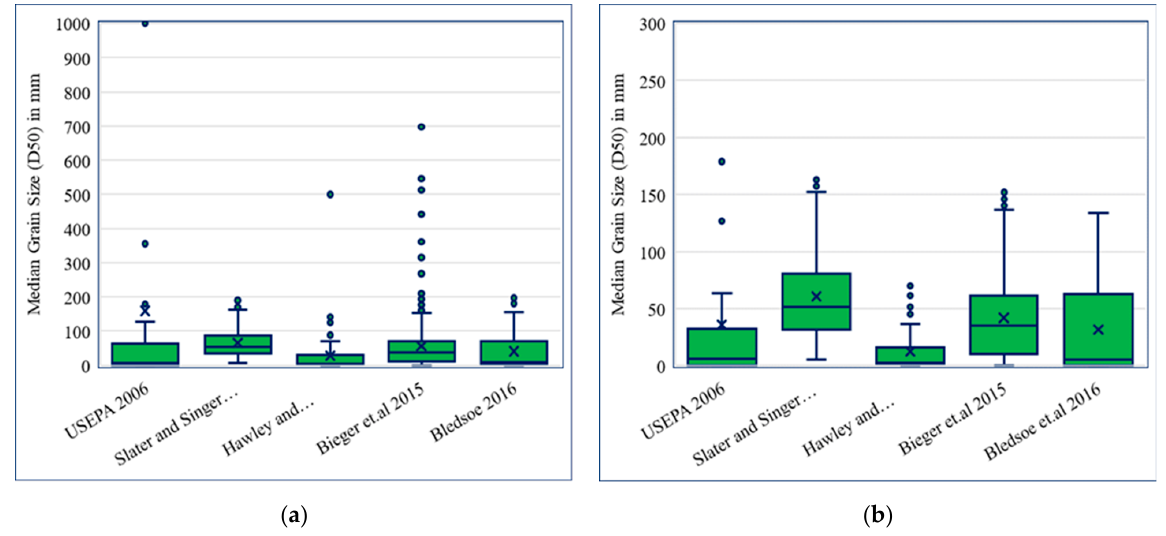
Figure 2. Box plots using D50 data values from five datasets: ( a ) original data, ( b ) after removing outliers. The outliers are designated by shaded circles, which are the values beyond the whiskers (lines extended up to 1.5 times the interquartile range) in both directions from the box. The box represents the range of 25th and 75th percentile. The horizontal line within the box and the ‘x’ sign represent median and average values respectively. Outliers are designated by shaded circles. Table 2. Descriptive Statistics for the D50 data obtained from the five sources.